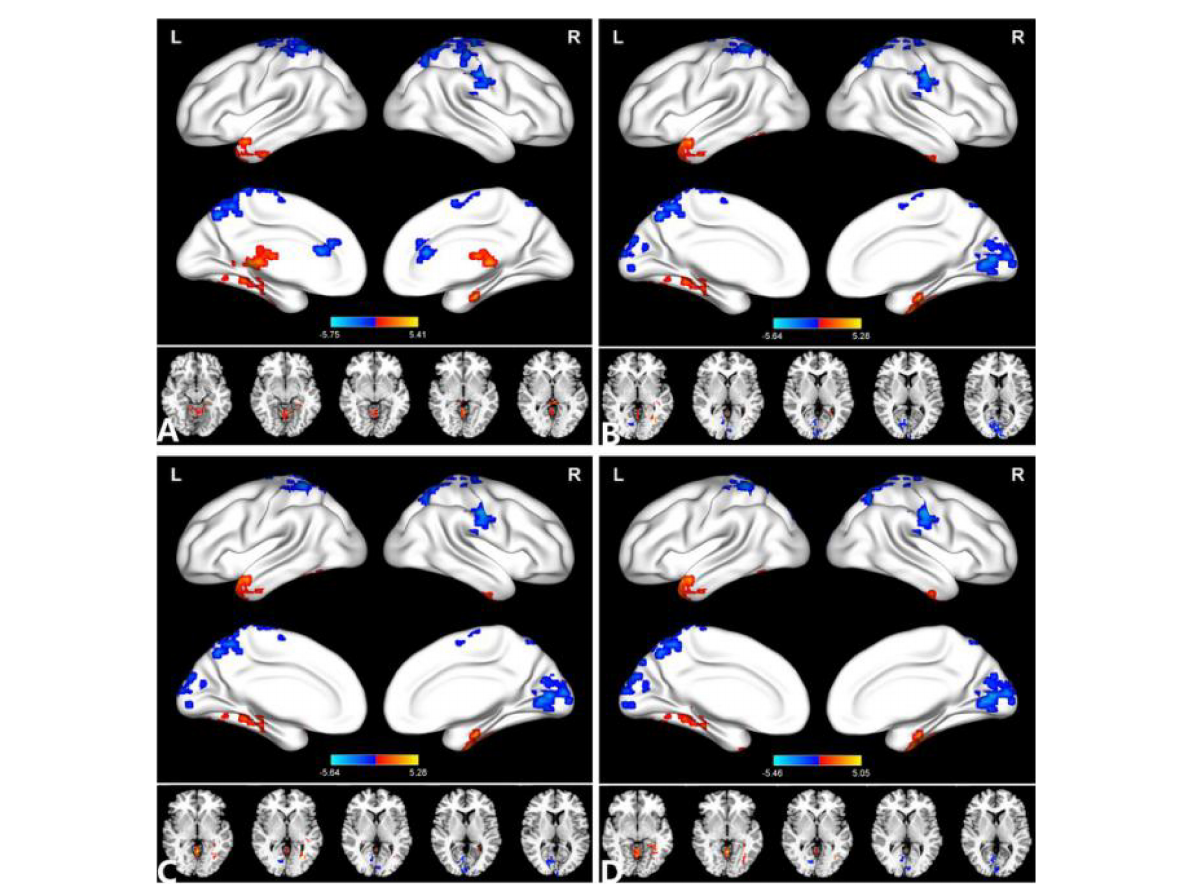
FIGURE2 Comparison of the DC between the PACG and HC. (A) ( r = 0.15), (B) ( r = 0.20), (C) ( r = 0.25), (D) ( r = 0.30). Significant degree centrality differences were found between the two groups. The blue areas indicate lower degree of centrality values (two-tailed, voxel-level P < 0.01, GRF correction, cluster-level P < 0.05). GRF, Gaussian random field; L, left hemisphere; MOG, middle occipital gyrus; and R, right hemisphere.